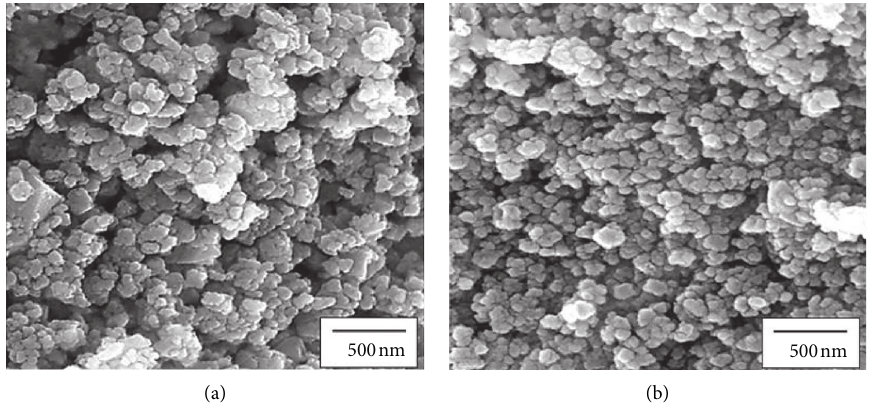
Figure 5: SEM image of sintered powder: (a) electrical resistance heating sintered; (b) microwave